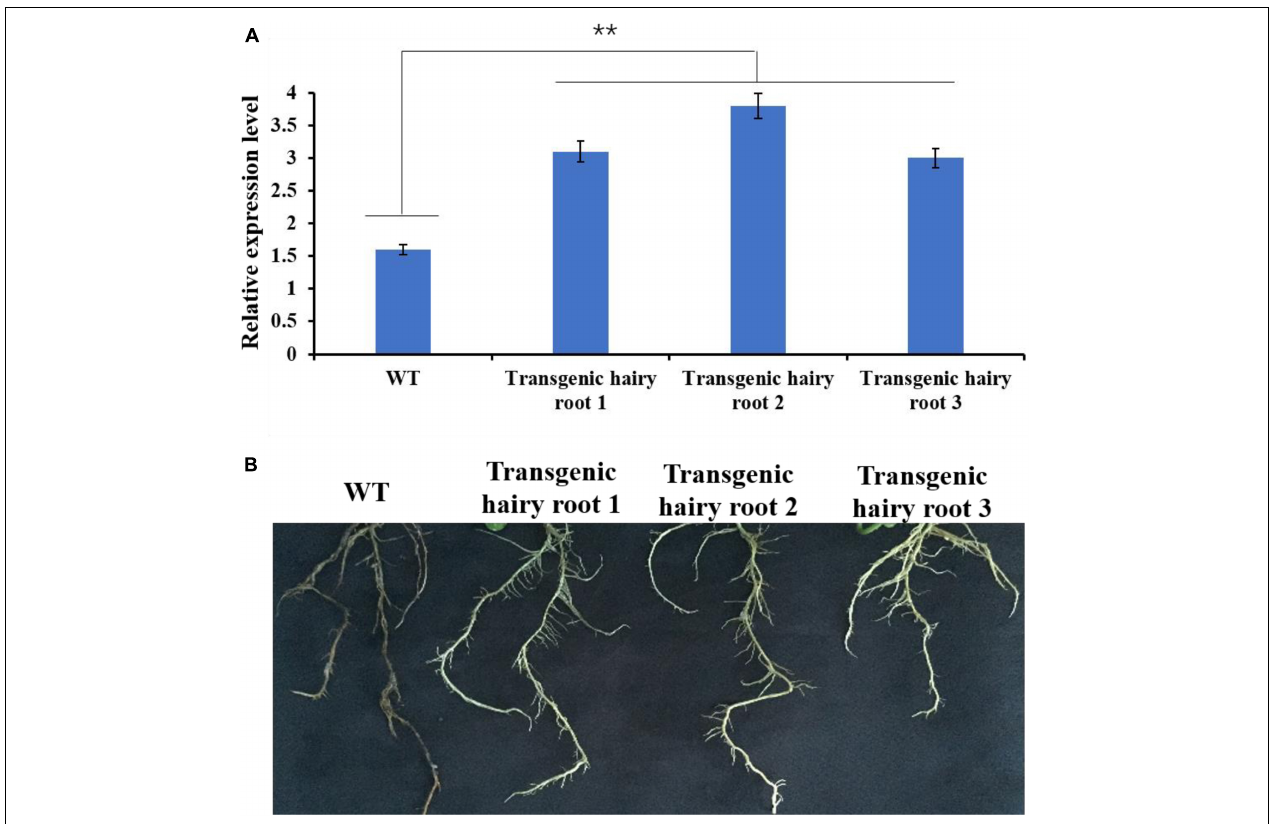
FIGURE 7 | The effects of GmMT1 overexpression on Phytophthora sojae resistance. (A) The relative expression levels of GmMT1 in non-transgenic low-isoflavone soybean cultivar Donong50 (WT) and three transgenic Donong50 lines overexpressing GmMT1. ** indicates a significant difference between WT and transgenic hair roots ( P < 0.01, Student’s t- test). (B) Phenotypic differences in hairy roots of transgenic and non-transgenic soybeans after P. sojae